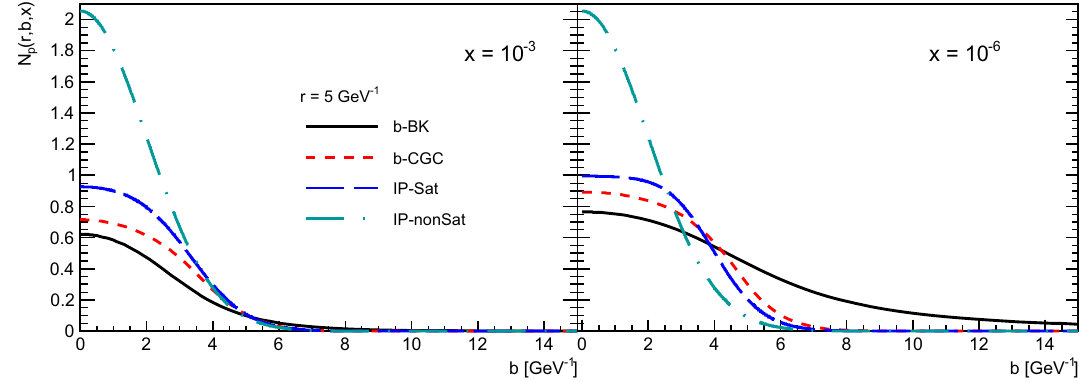
Fig. 2 Predictionsofthedifferentnonlinearapproachesfortheimpact–parameterdependenceofthedipole-protonscatteringamplitudeconsidering two distinct values of x ( = 10 − 3 and 10 − 6 ) and a fixed dipole size ( r = 5 GeV − 1